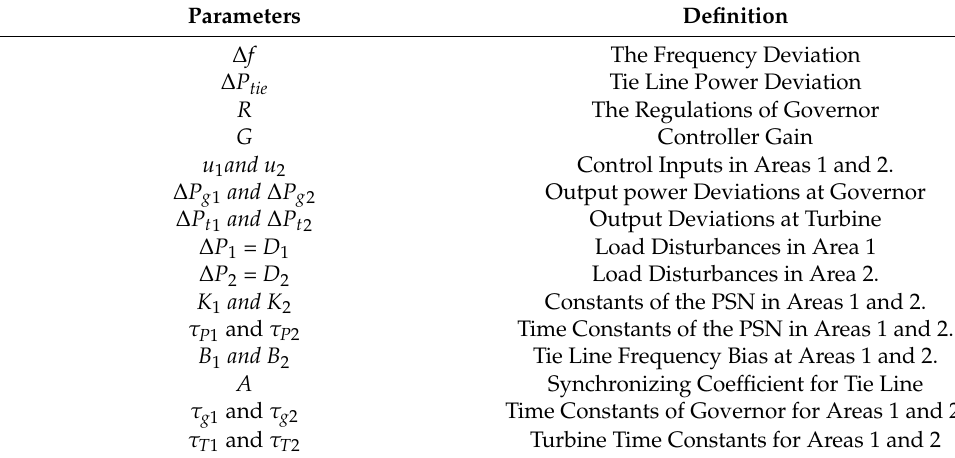
Figure 7. The block diagram of a two-area PSN based on a state space model.